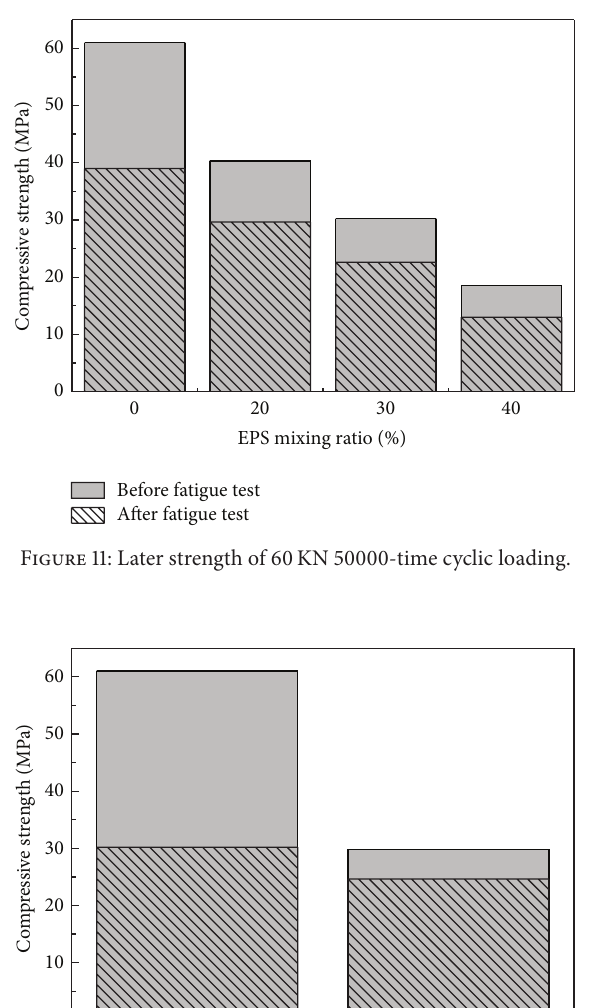
test. The compressive strength of EPS concrete